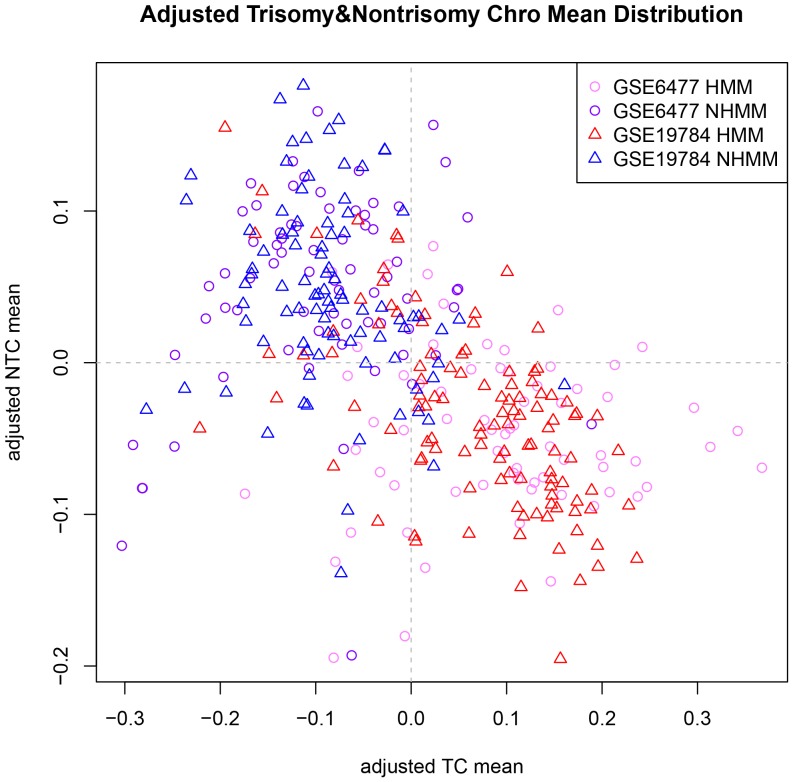
Scatterplot of adjusted trisomy and nontrisomy chromosome means of both GSE6477 and GSE19784 samples.Adjusting and overlapping the distributions of GSE6477 and GSE19784 makes classification more accurate. For all the sample points in a dataset from Figure 4, we shift their locations by the same amount, so the center of the samples points locates at (0, 0).